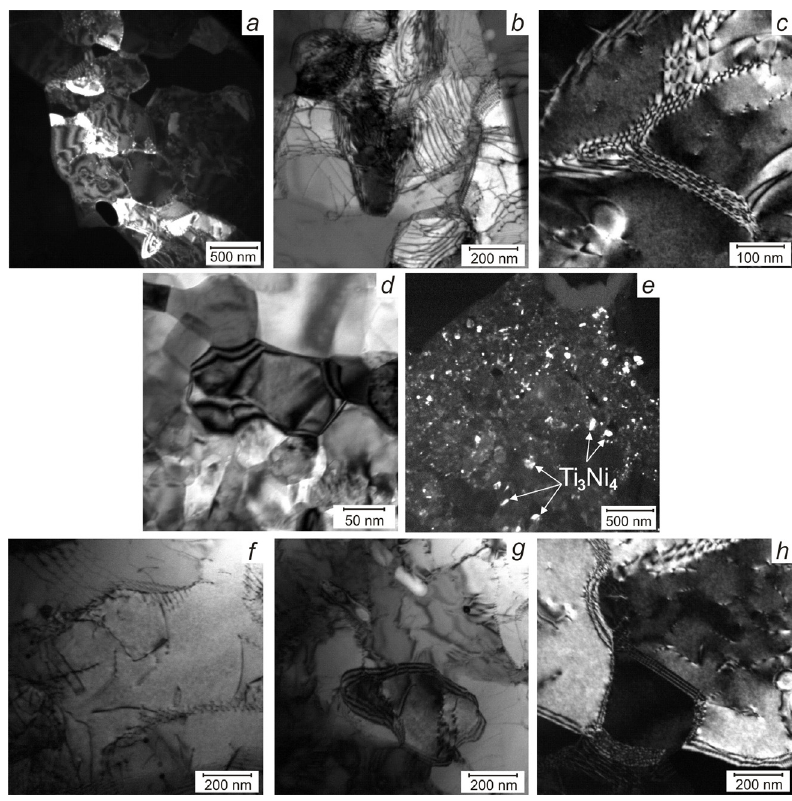
Figure 4. TEM images of areas with high curvature of the crystal lattice and dislocations of TiNi wire ( a–c ); areas with inhomogeneous contrast of displacement bands and with uniformly distributed finely dispersed T 3 Ni 4 phases of TiNi–Ag 0.1 wire ( d,e ); areas with dislocation defects of TiNi–Ag 0.2 wire ( f–h ).